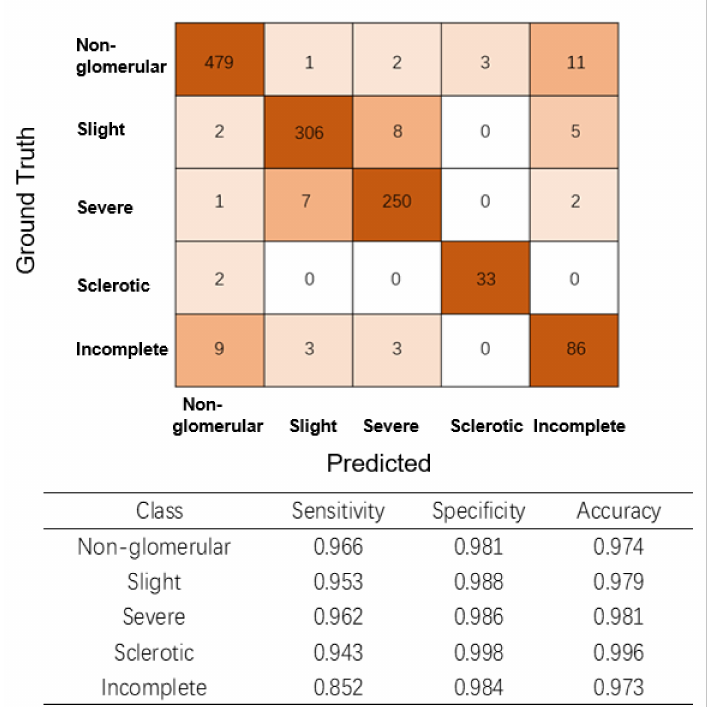
Figure 4. Glomerulus classification confusion matrix and performance. The ground-truth categories and labels predicted by the model are shown horizontally and vertically, respectively. The confusion matrix demonstrates the distributions of correct and incorrect classifications among different